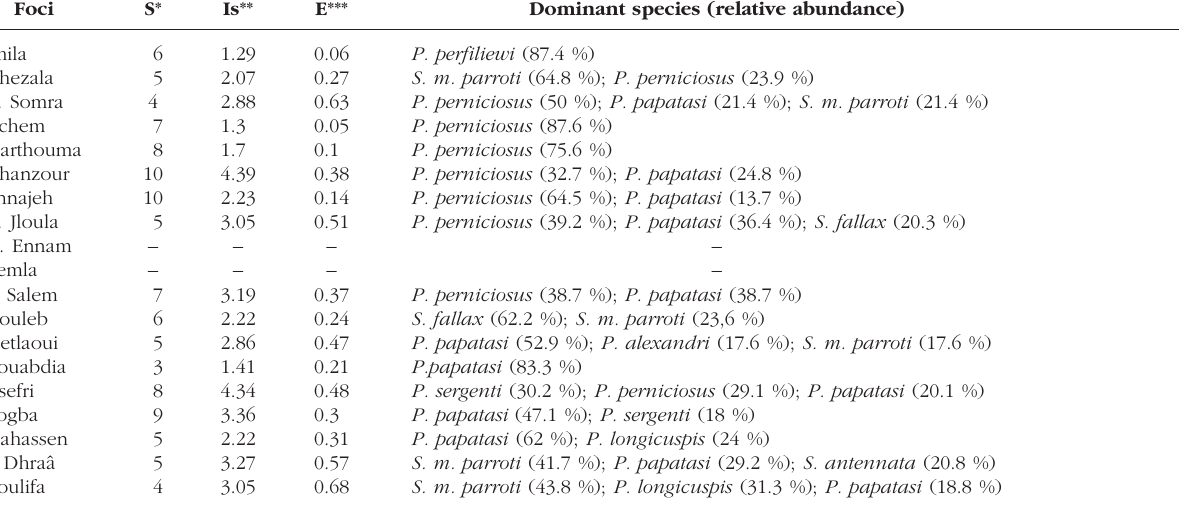
Table IIa. – Diversity and dominant species of phlebotomine caught on CDC traps in leishmaniosis sites.